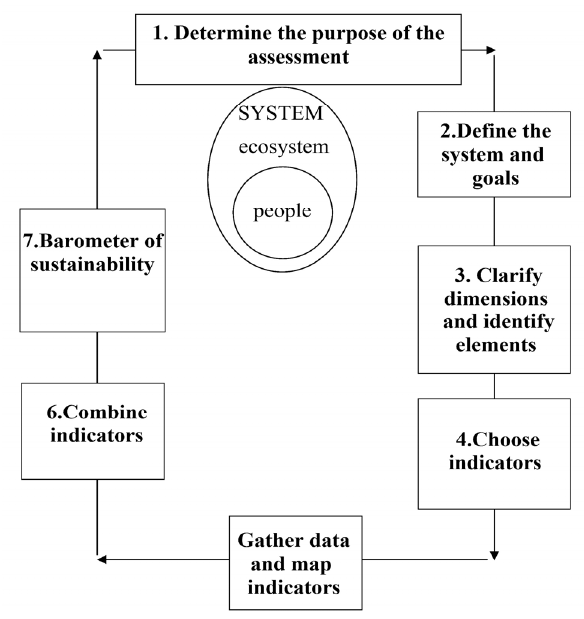
Figure 3. Seven stages of the IUCN approach cycle.